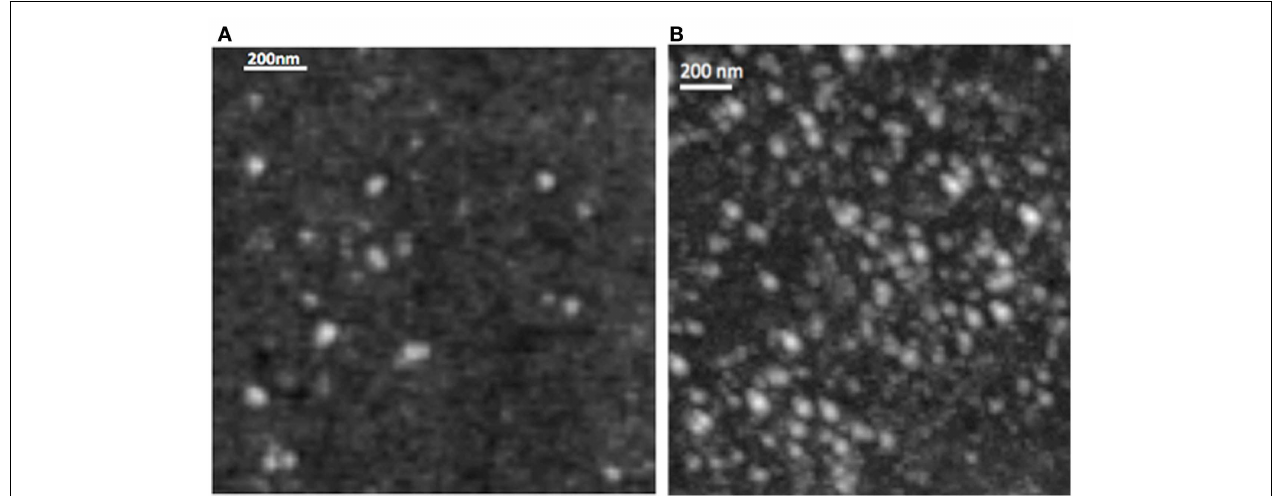
FIGURE 5 | Morphology of rHDL/ATRA (A) and of rHDL/FR (B) nanoparticles withAtomic Force Microscopy.